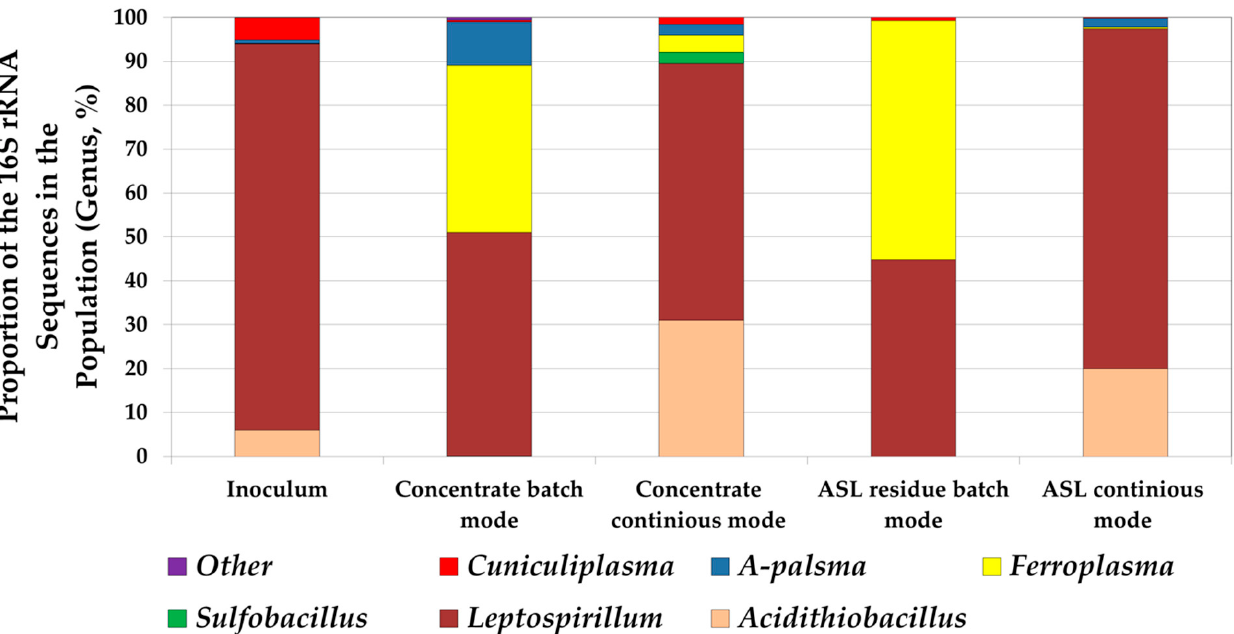
Figure 5. Analysis of microbial populations performing bioleaching under different conditions (proportion of the 16S rRNA gene fragment).